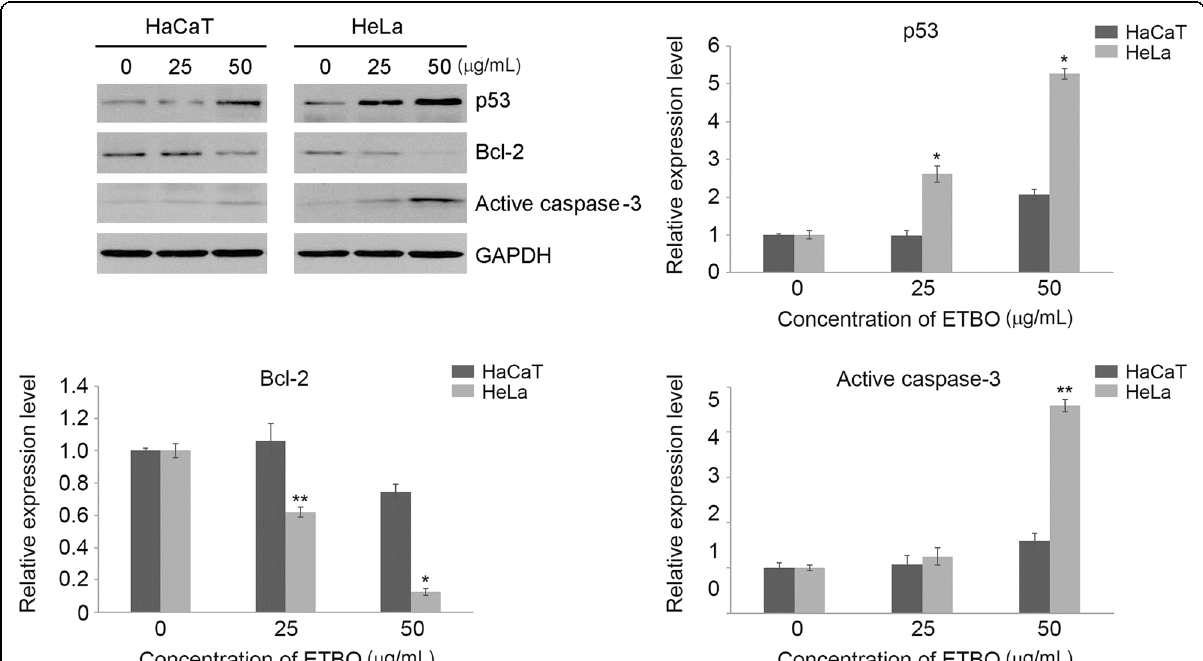
Fig. 5 Western blot analysis for apoptosis-related proteins, caspase-3, Bcl-2, and p53. The results are the means ± SD, n = 3. * p < 0.05, ** p < 0.01 between the control and ETBO-treated